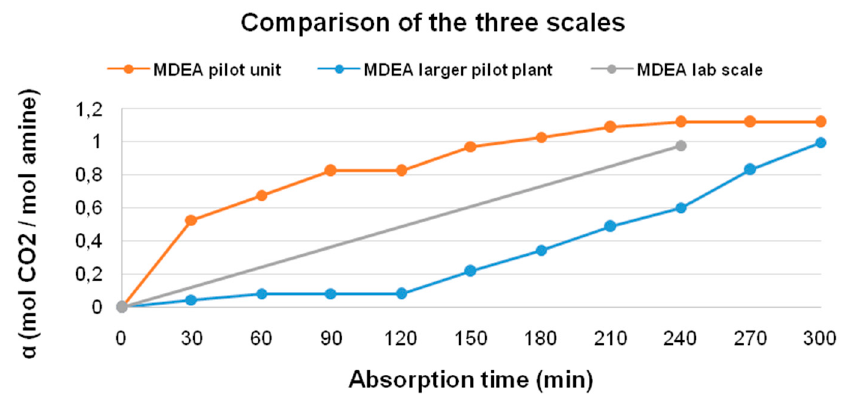
Figure 6. Comparison of the obtained results for CO 2 loading capacity ( α ) over the absorption time for the tested aqueous MDEA solution (20 wt %) in the three different testing scales. Table 2. Results from CO 2 absorption by the aqueous methyldiethanolamine (MDEA) solution at 20% ( w / w ) in the small pilot unit.